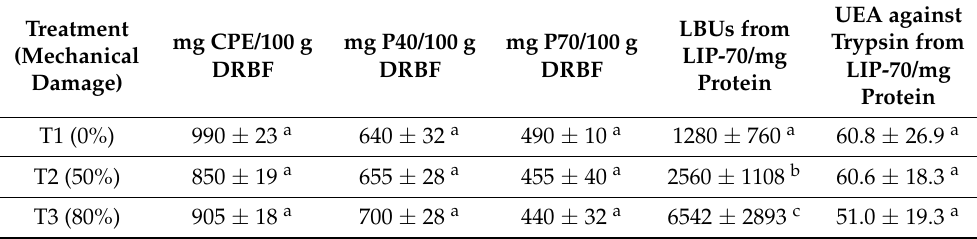
Table 3. Purification of protein, lectin binding units and units of enzymatic activity against trypsin in the different treatments of Tepary bean plants ( Phaseolus acutifolius ).